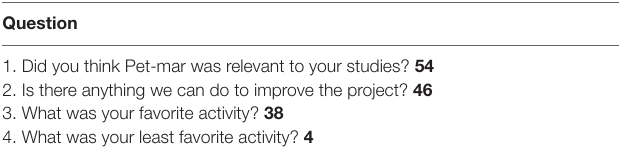
TABLE 3 | PERMANOVA test on differences in students’ questionnaire scores across period (initial and final) and gender (male, female, and other/not mentioned) as fixed and orthogonal.